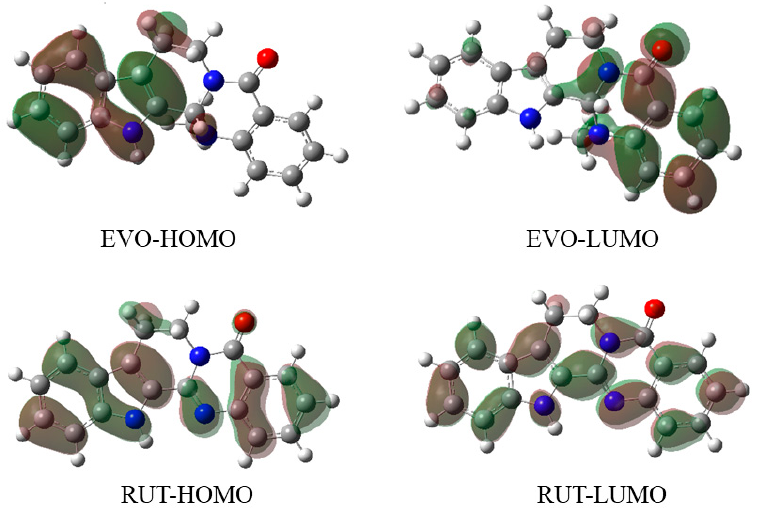
Figure 3. Calculated isodensity surface plots of the frontier molecular orbitals of evodiamine (EVO) and rutaecarpine (RUT). Red color represents positive orbitals and green color represents negative orbitals.